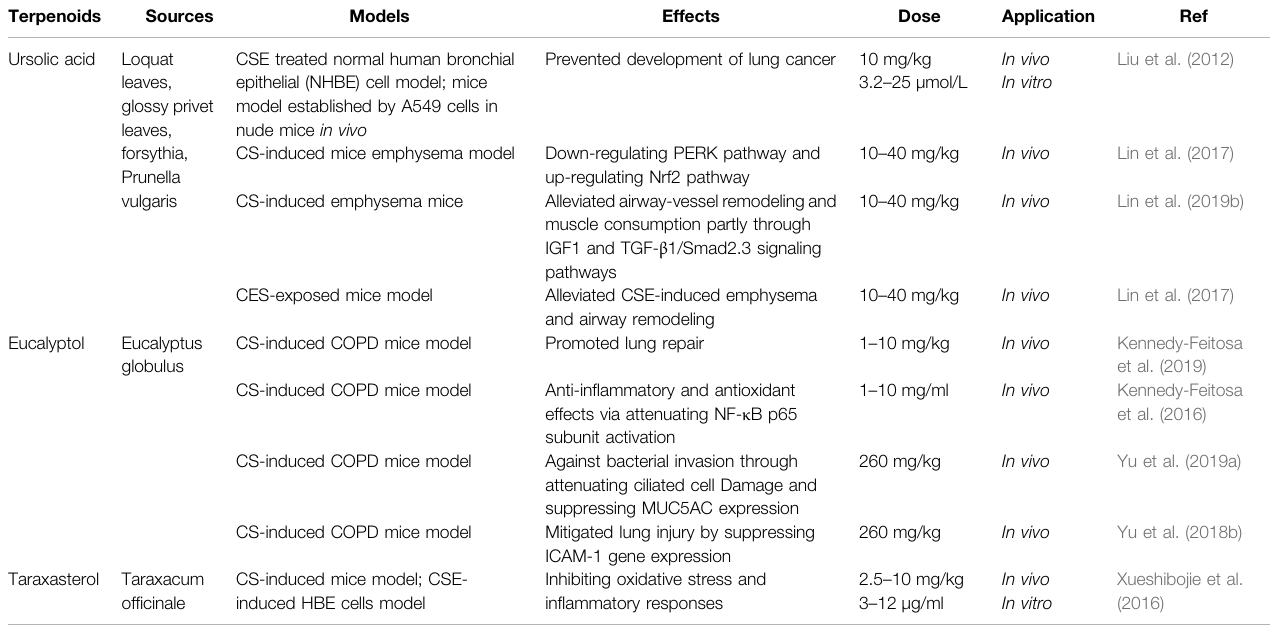
TABLE 5 | The effects of terpenoids on